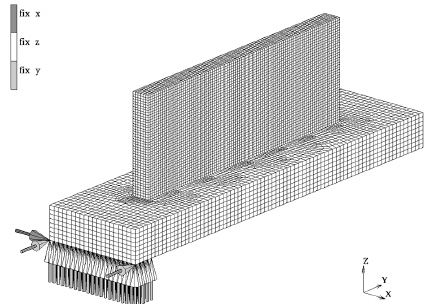
Figure 4. Model with fine mesh. The arrows indicate the mechanical boundary conditions used for all models.